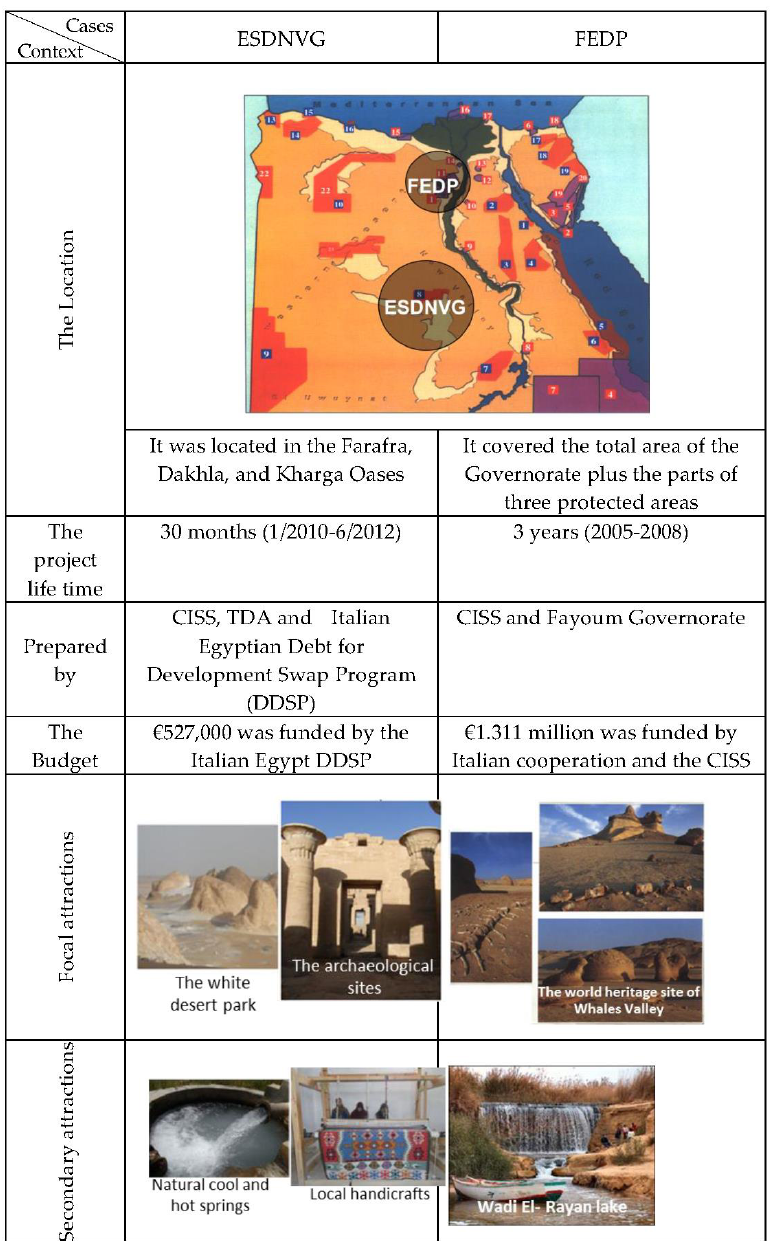
Figure 3. The contexts and locations of the case studies CISS: Cooperation Internationale Süd-Süd. Source: The author based on (CISS and EDG 2008, 2012).